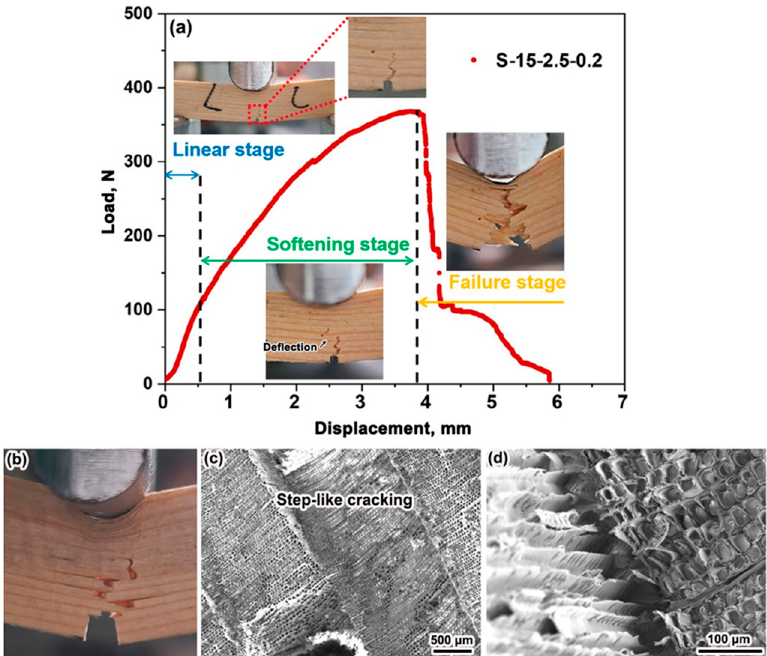
Figure 3. Simplified three-stage quasi-brittle fracture process ( a ), the side view under testing ( b ), and detailed morphologies of the fracture surface ( c , d ) of the PSV sample.